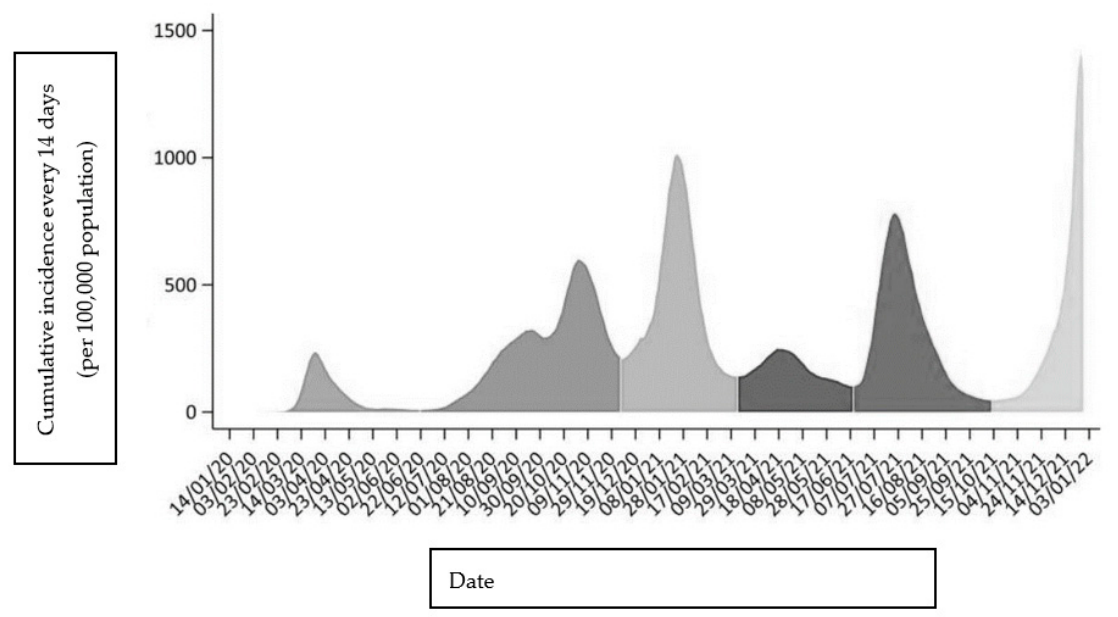
Scheme 1. Epidemic curve of the pandemic in Madrid showing the different periods of incidence growth. Data were extracted from individualized data reported to RENAVE [4].